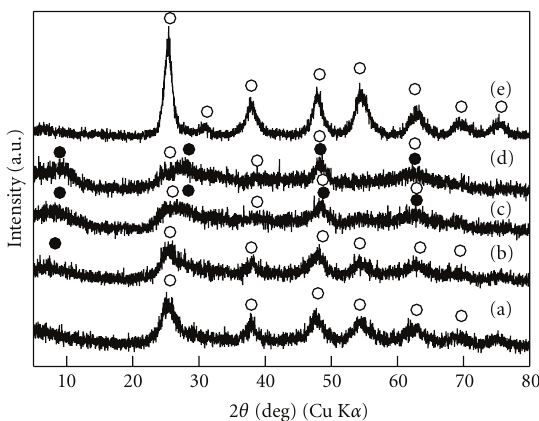
Figure 1: XRD patterns of the obtained particles by heating a mixture of ethylene glycol solution of TIP and NH 3 (aq) at 368 K for 24h. The NH 3 (aq) concentrations were (a) 0.1 mol/L, (b) 0.2mol/L, (c) 0.5mol/L, (d) 1 mol/L, and (e) the particles obtained by heating the mixture of TIP and H 2 O at 368 K for 24 h. (cid:3) : anatase TiO 2 and (cid:2) : layered titanic